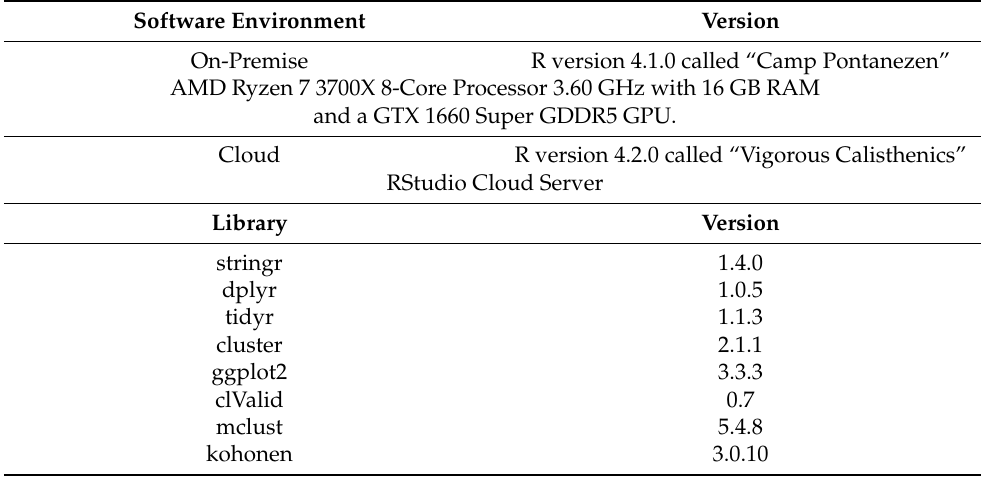
Table 2. Libraries and Software